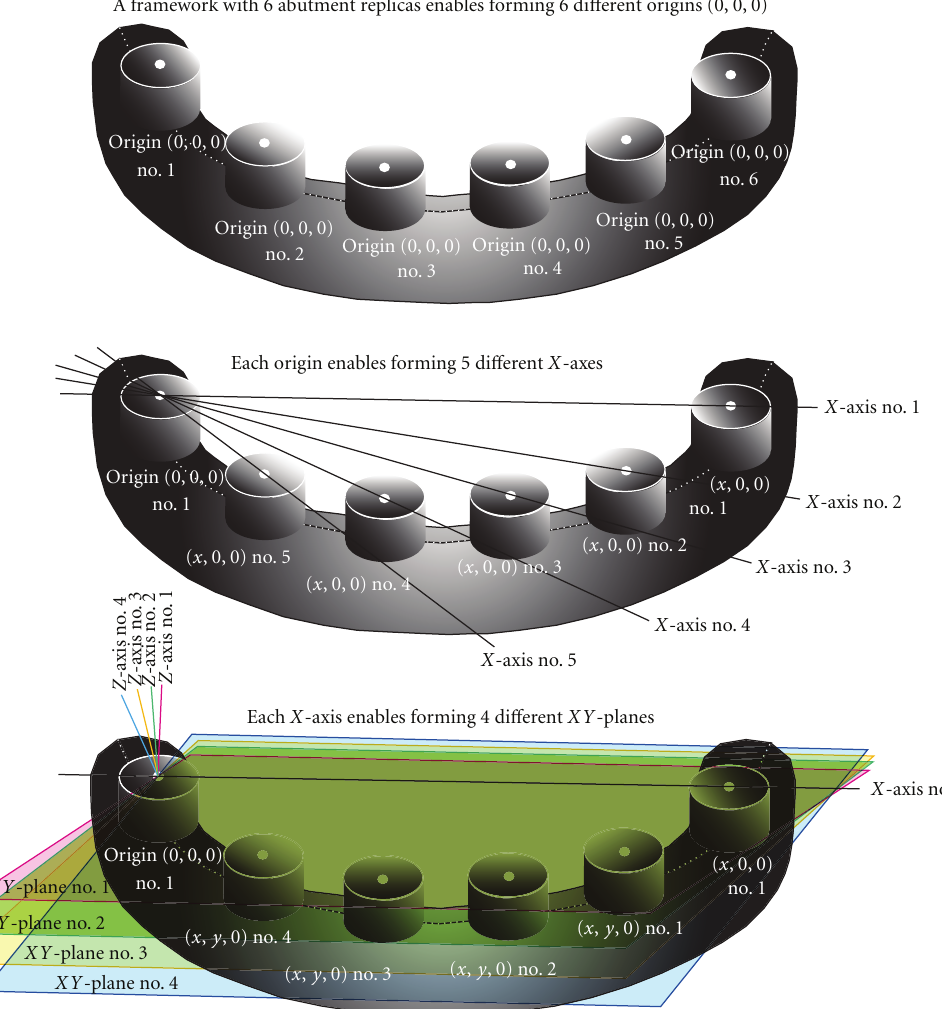
Figure 1: The unfixed matching coordinate system method: 120 possible matching rectangular coordinate systems for a framework containing 6 abutment replicas (possible to form: 6 Origins × 5 X -axes × 4 XY -planes = 120 coordinate